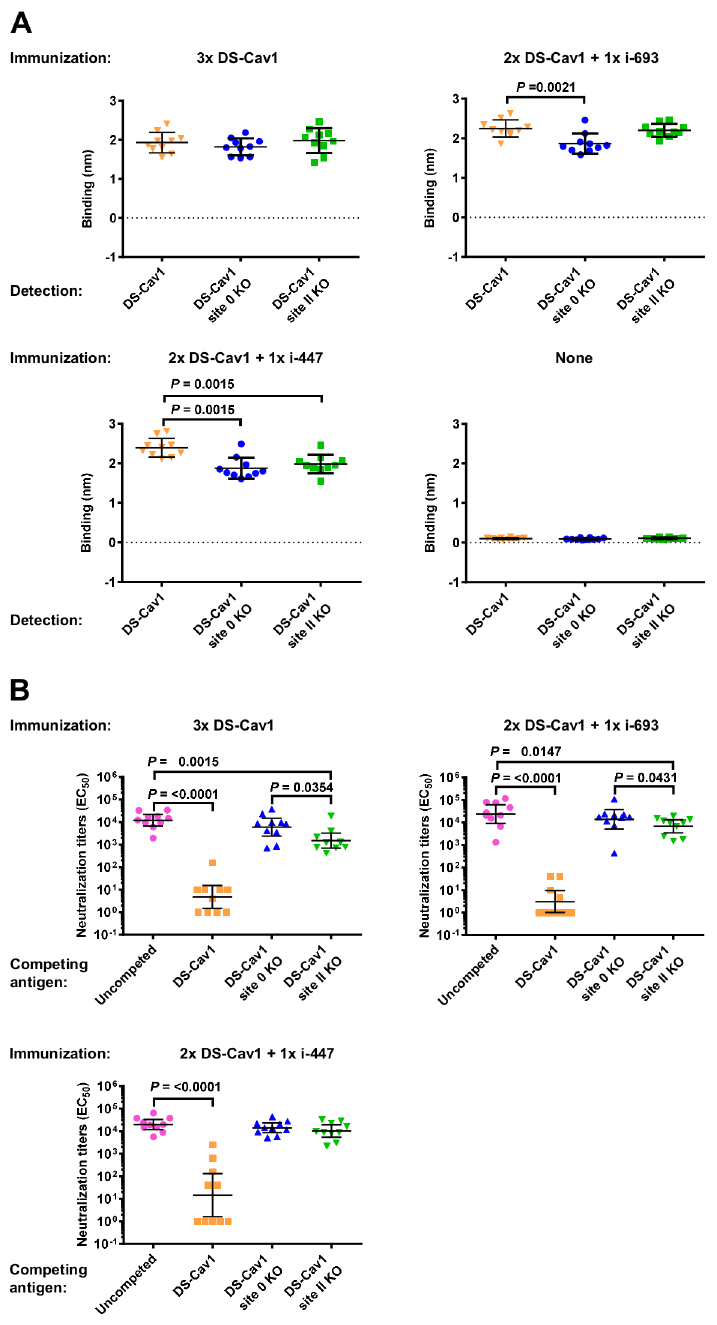
Fig 5. Boost by head-only RSV F immunogen can focus the RSV-neutralizing response to antigenic sites Ø and II. (A) Recognition of DS-Cav1, DS-Cav1 site Ø knockout (KO) and DS-Cav1 site II KO probes by sera from 2×DS-Cav1 immunized mice boosted with DS-Cav1, i-447 or i-693, respectively or unimmunized mice. (B) Neutralization competition of sera from 2×DS-Cav1 immunized mice boosted with DS-Cav1, i-447 or i-693, respectively. P values for differences between DS-Cav1 and DS-Cav1 site Ø or site II KO probes were all < 0.0001. P values were determined by two-tailed Mann-Whitney